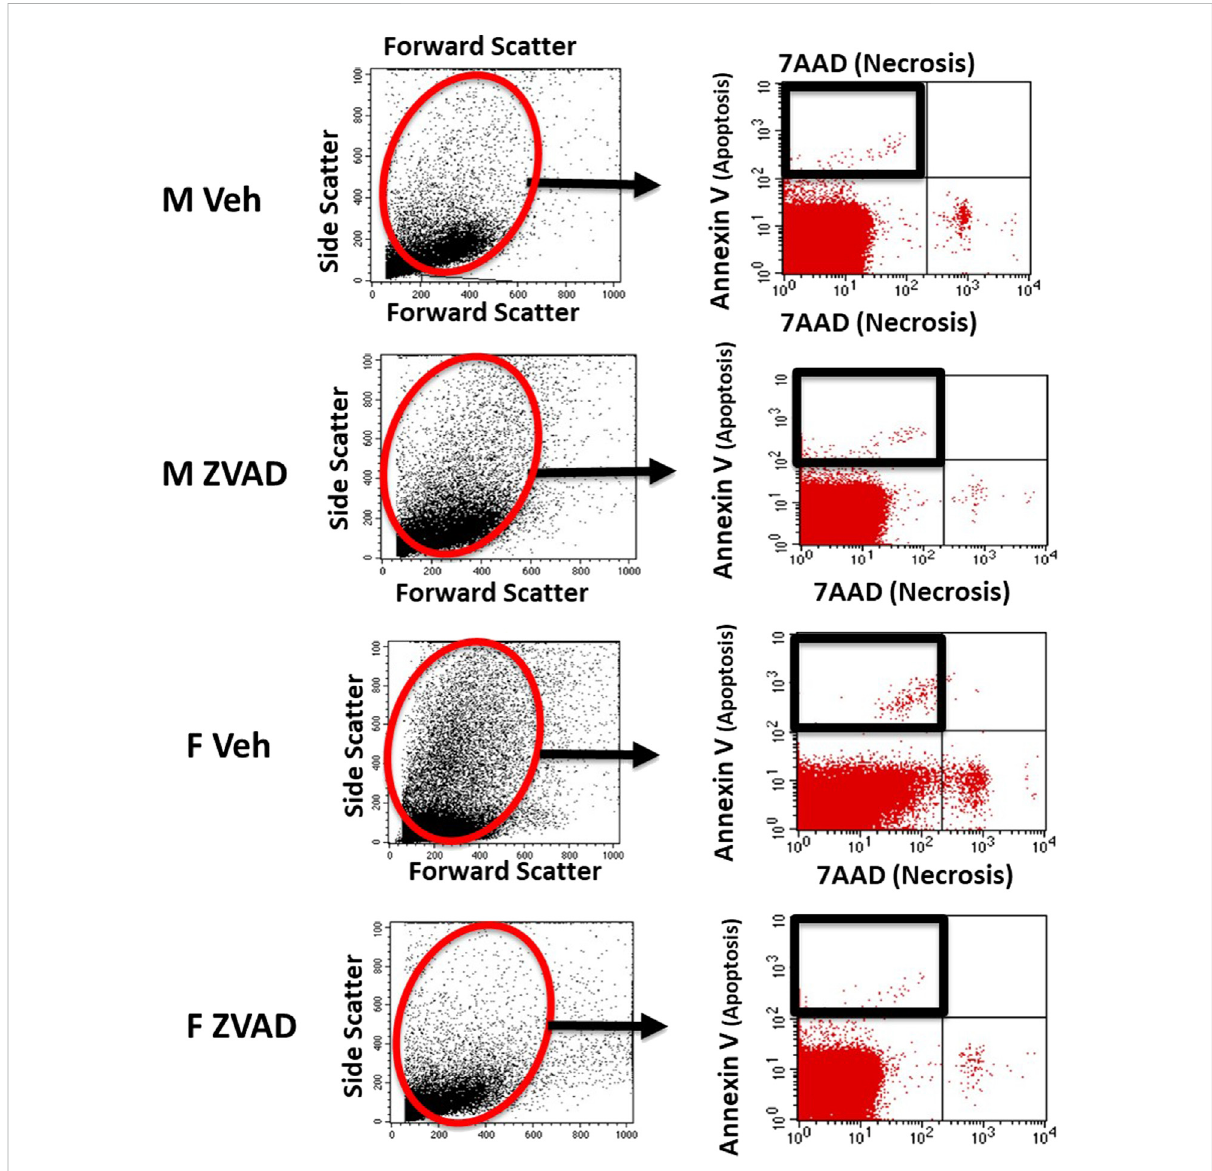
FIGURE 1 Apoptosis was analyzed by fl ow cytometry. Shown are representative scatterplots of fl ow cytometry gating strategy showing the selection of single cells and exclusion of cell debris based on forward scatter and side scatter.